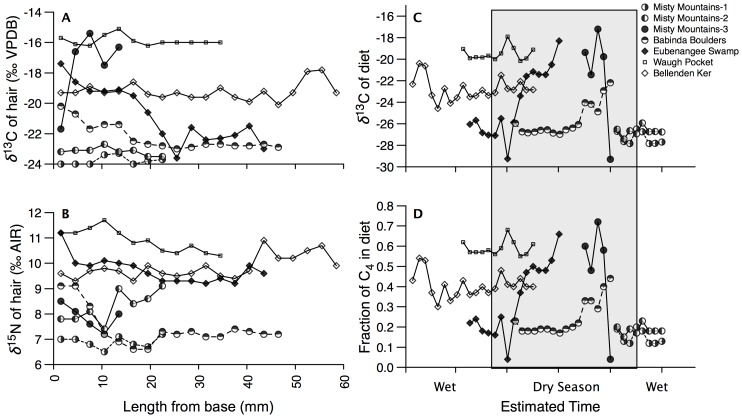
Plot of δ13C vs. δ15N values of sequential feral pig hair from seven individuals.Specimen legend as in Figure 4.